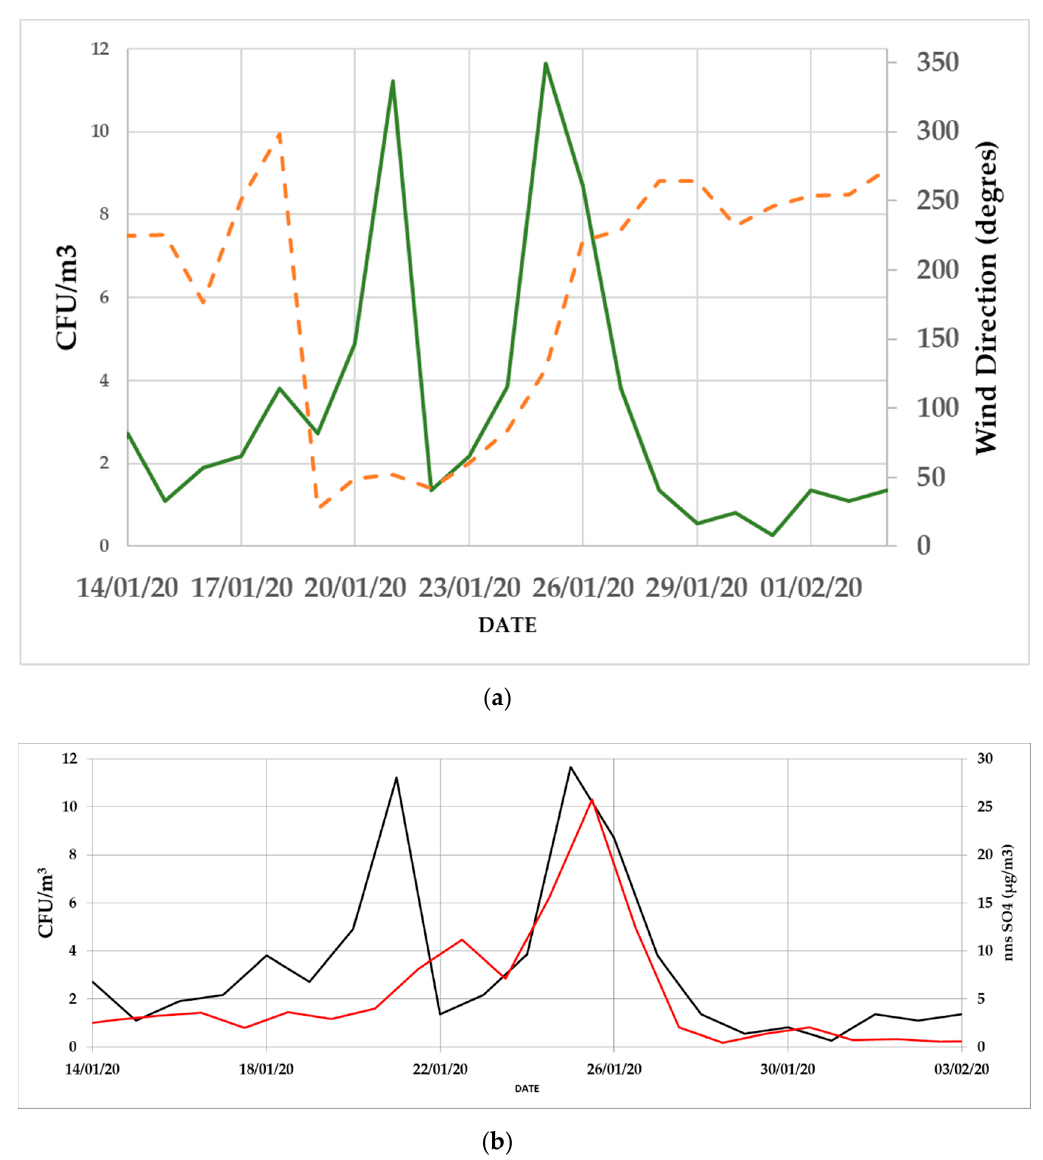
Figure A5. Variability of Wind direction in Degrees° (orange curve) and culturable bacterial concentrations in CFU/m 3 (green curve) ( a ) and ( b ) variability of non-sea salt sulfate (nss) concentrations in µg/m 3 (red curve) and culturable bacterial concentrations in CFU/m 3 (black curve) from 14